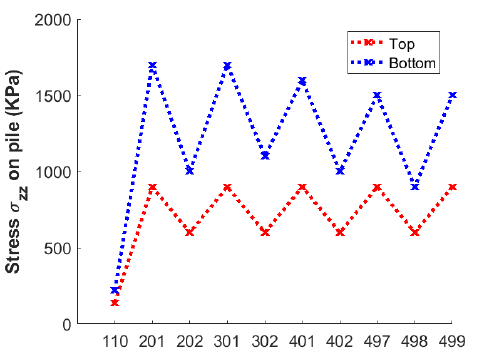
Fig. 7. Stresses σ zz at the top and bottom of the granular layer above one